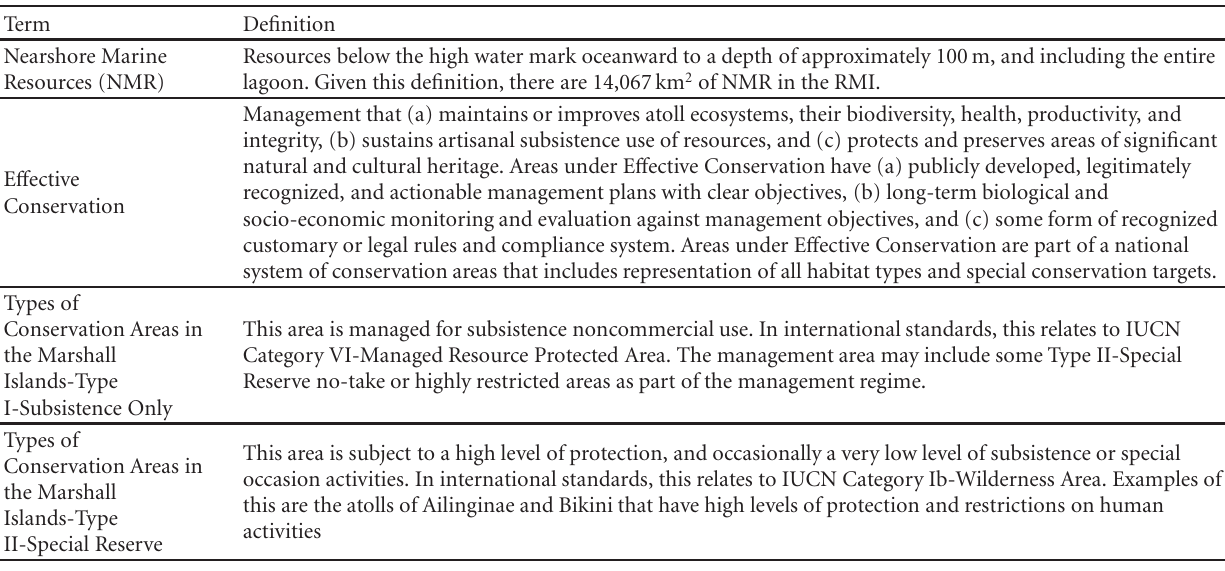
Table 1: Definitions of Reimaanlok concepts and terms as developed in workshops.